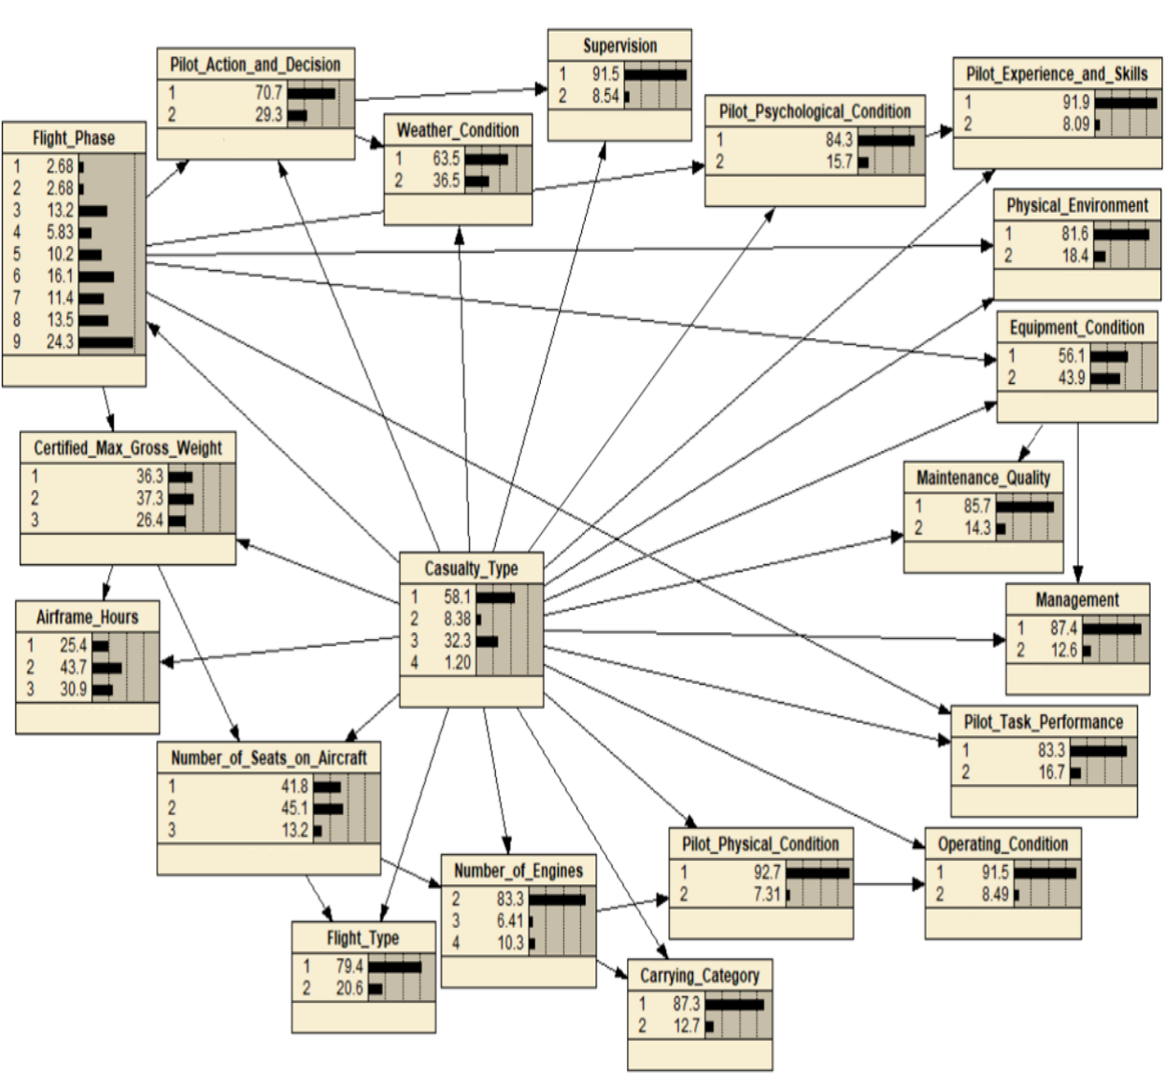
Figure 1. Structure and results of the proposed TAN-BN model.